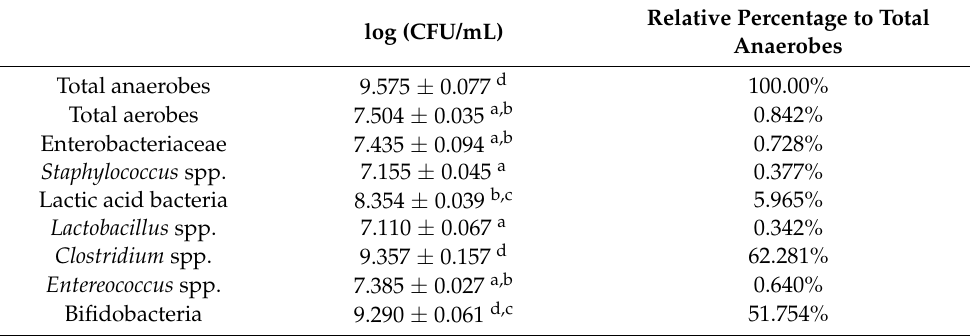
Table 5. Microbial count in fecal inoculum.